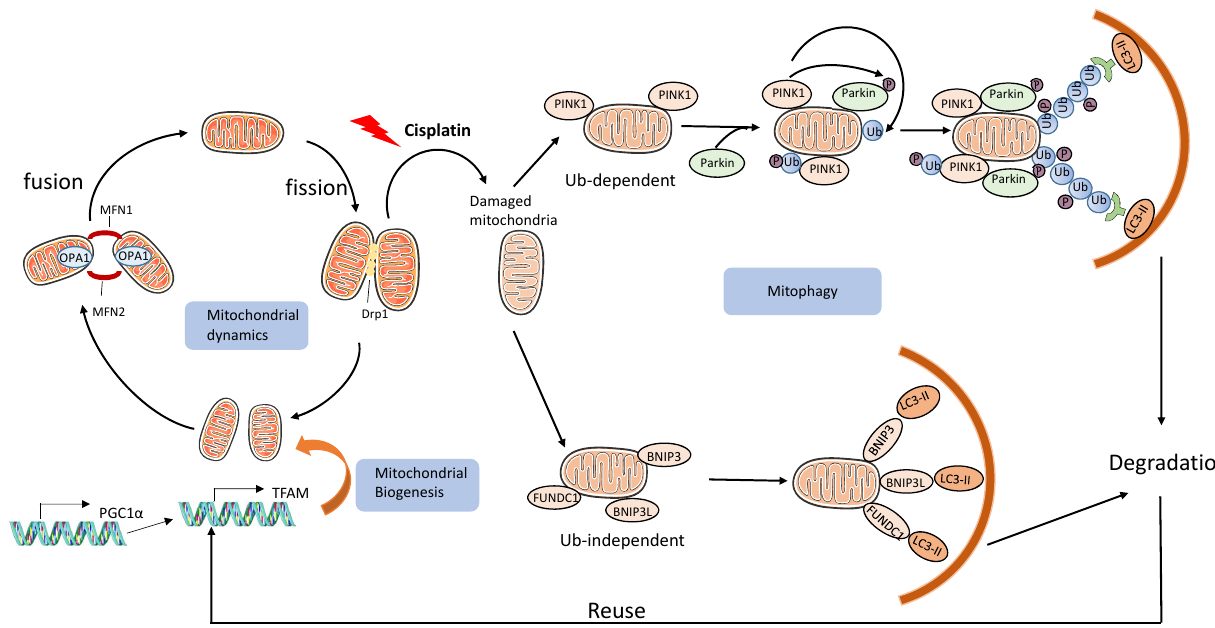
Figure 2. Mitochondrial quality control in cisplatin injury. Mitochondria biogenesis, dynamics, and mitophagy are important mechanisms of mitochondrial quality control. PGC-1 α and TFAM are two important transcription factors for mitochondrial biogenesis. The life cycle of mitochondria begins with the growth and division, and ends with the degradation via mitophagy. In cisplatin nephrotoxicity, mitochondria are damaged and then eliminated by